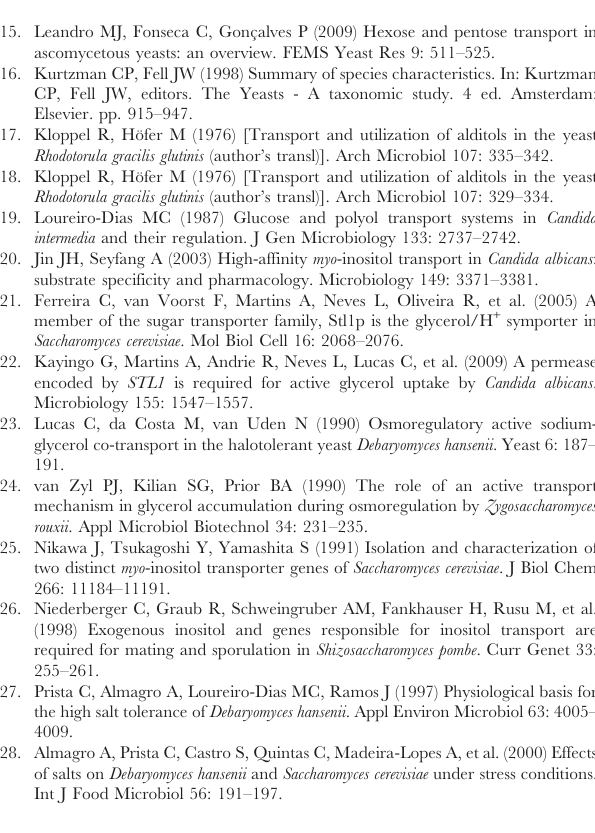
Figure S1 Representative alignment of characterized D. hansenii polyol transporters. Analysis was performed using MUSCLE web server [54] for multiple alignments. Conserved